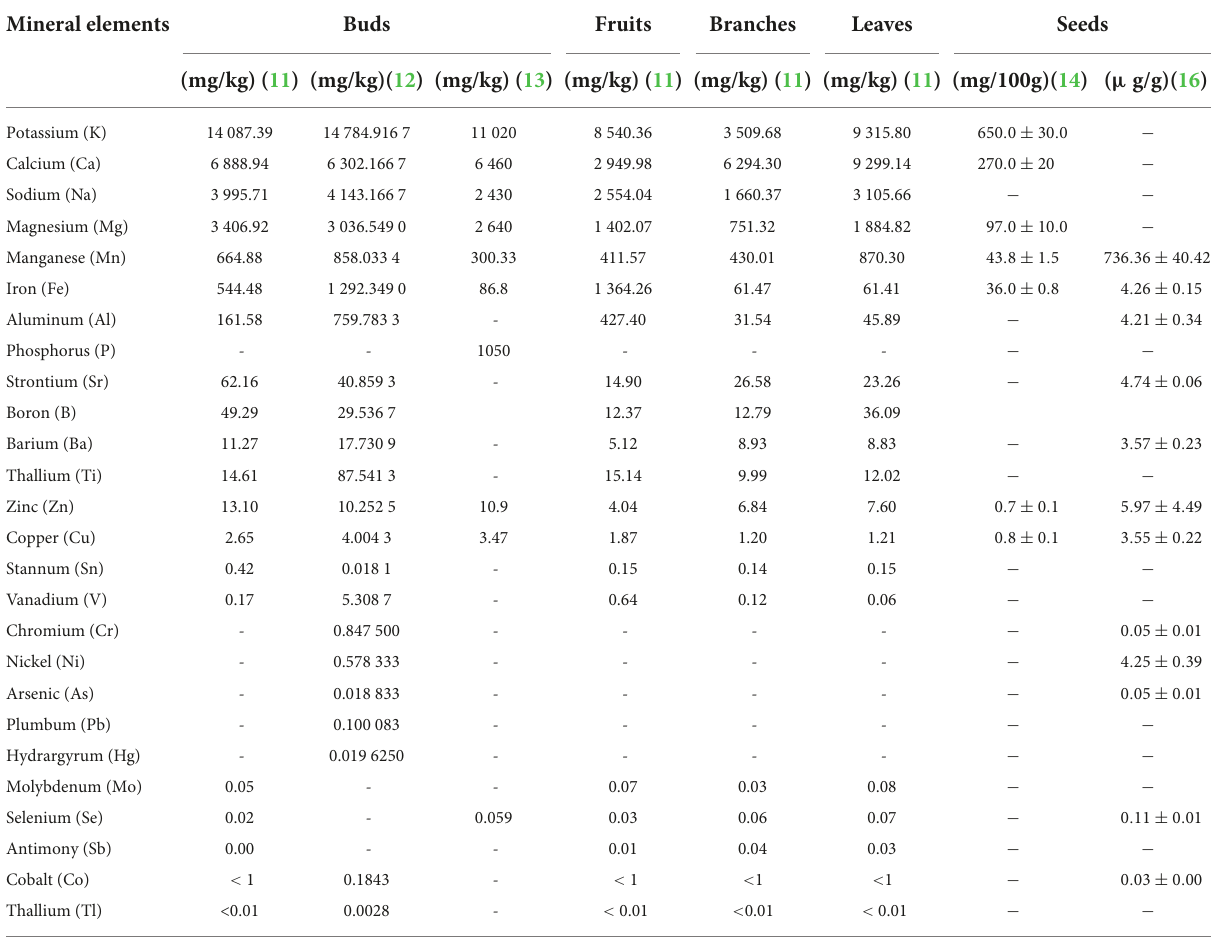
TABLE 3 Mineral elements content in various parts of S. aromaticum . Mineral elements Buds Fruits Branches Leaves